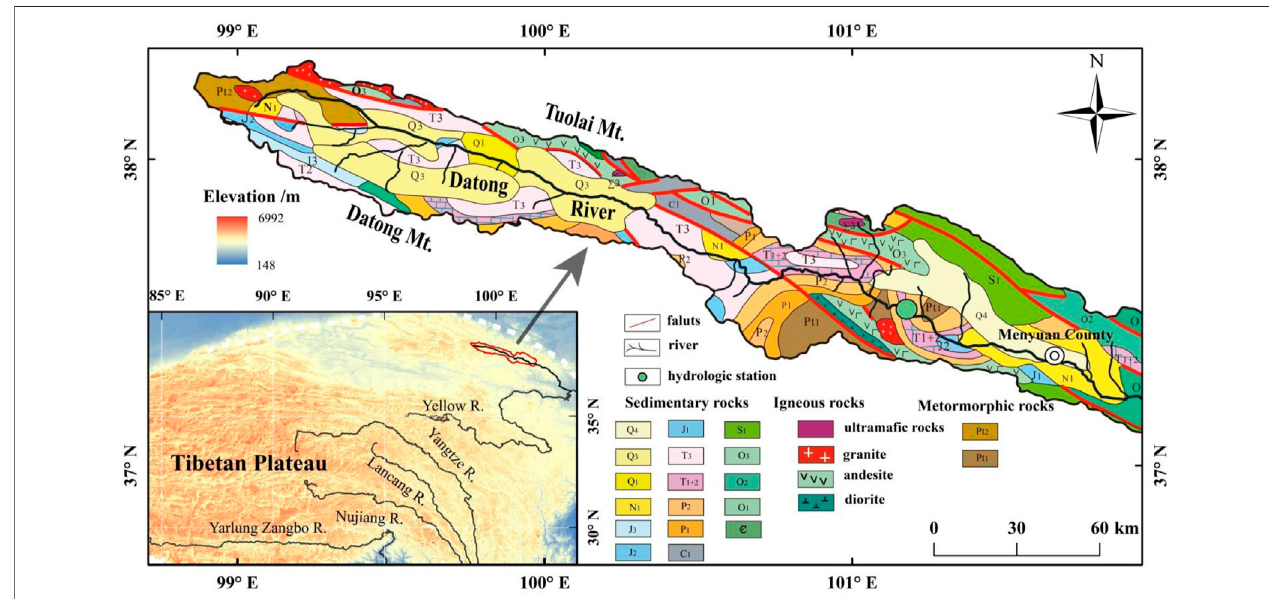
FIGURE1| GeologicalmapandlocationoftheDatongRiverbasinattheupperreachoftheYellowRiver.Thegreencycleistheweeklysamplingsiteofriverwaters in the Datong River at the Qingshizui hydrological station.